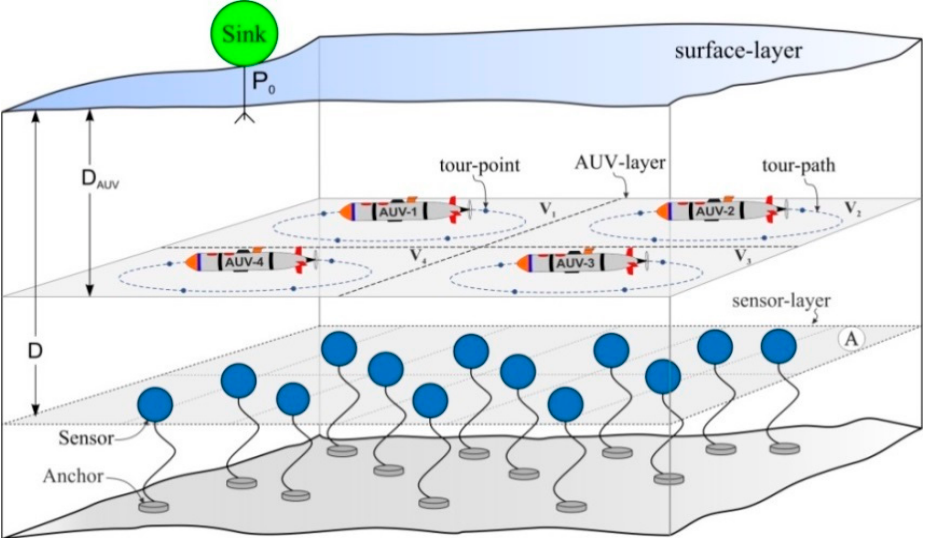
Figure 1. Proposed Network Architecture in a 3-dimensional region, R 3 .